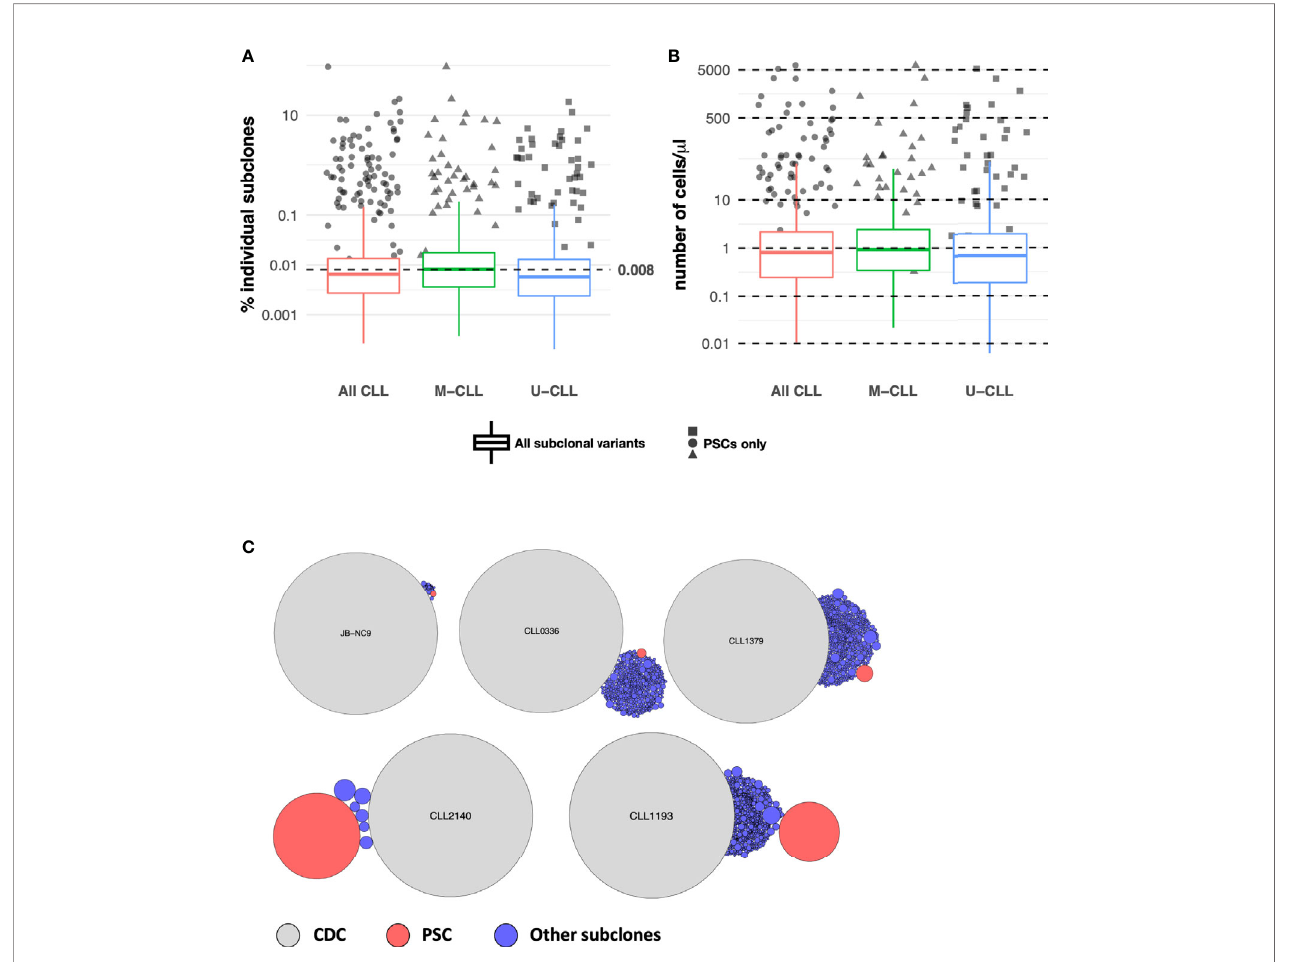
FIGURE 3 | Subclonal variant cell counts. (A) PSCs are numerically expanded. Box plots indicate the percentage distribution of all post-CDC subclones. The solid colored dots represent the percentages of individual PSCs. The dotted horizontal line indicates the 0.008% sensitivity threshold used to de fi ne subclonal expansion (see Methods ). (B) Absolute numbers of distinct IGHV-D-J subclones per ul of individual patient blood samples estimated from sequencing data, fl ow cytometry, and absolute blood lymphocyte counts. Box plots and solid colored dots as in (A) . (C) Representative examples of the relative numbers of the post-CDC subclones (blue circles) and the PSCs (red circles) in relation to the CDC of fi ve samples analyzed in this